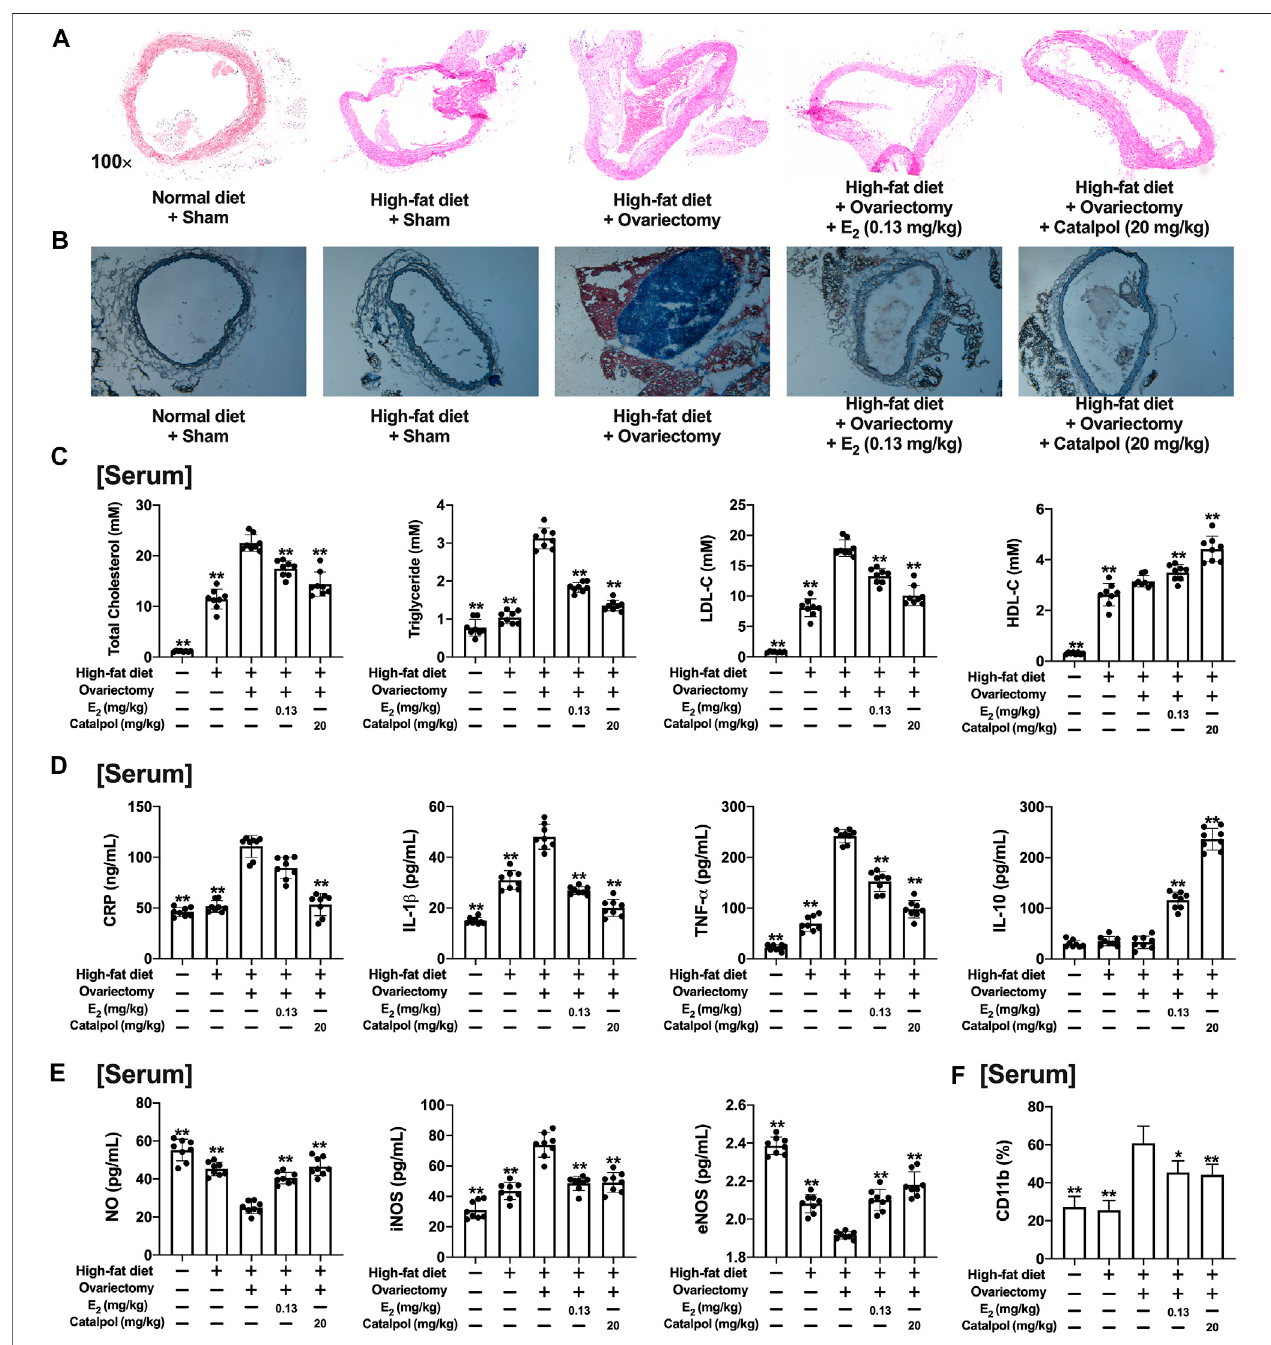
FIGURE 7 | Catalpol attenuated in fl ammatory response and oxidative stress in HFD-Ovx-treated ApoE − / − mice. Representative atherosclerotic lesions in cross- sections of the aortas were stained by H&E (A) and oil red O (B) ; (C) Effects of catalpol on the levels ofserum lipid (TC, TG, LDL-C, and HDL-C) after 90 days ( n (cid:2) 8); (D) Effects ofcatalpol on the levels of in fl ammatory cytokines (CRP, IL-1 β , TNF- α , and IL-10) in HFD-Ovx-treated ApoE − / − mice ( n (cid:2) 8); (E) Effects of catalpol on the levels of NO, iNOS, and eNOS in HFD-Ovx-treated ApoE − / − mice ( n (cid:2) 8); (F) Effect of catalpol on the level of CD11b in HFD-Ovx-treated ApoE − / − mice ( n (cid:2) 8); Data are expressed as mean ± SD. * p < 0.05, ** p < 0.01 vs. Ovx group.